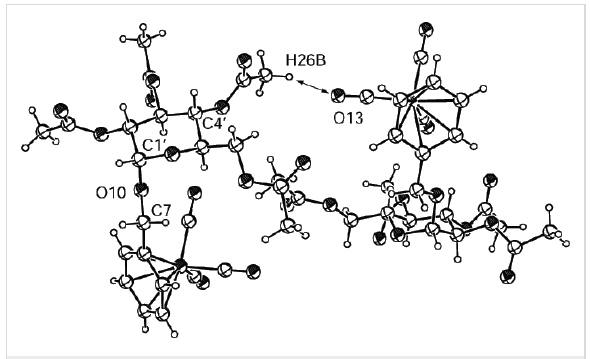
Figure 3: ORTEP-plot of the asymmetric unit showing two molecules of compound 2b and 30% probability ellipsoids; the arrows show the nonclassical H-bonds between O13 and H26B.